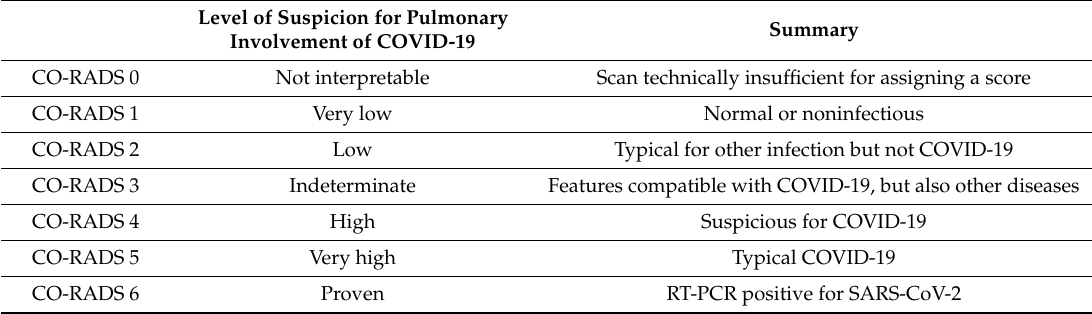
Table 1. CO-RADS categories and the corresponding level of suspicion for pulmonary involvement of